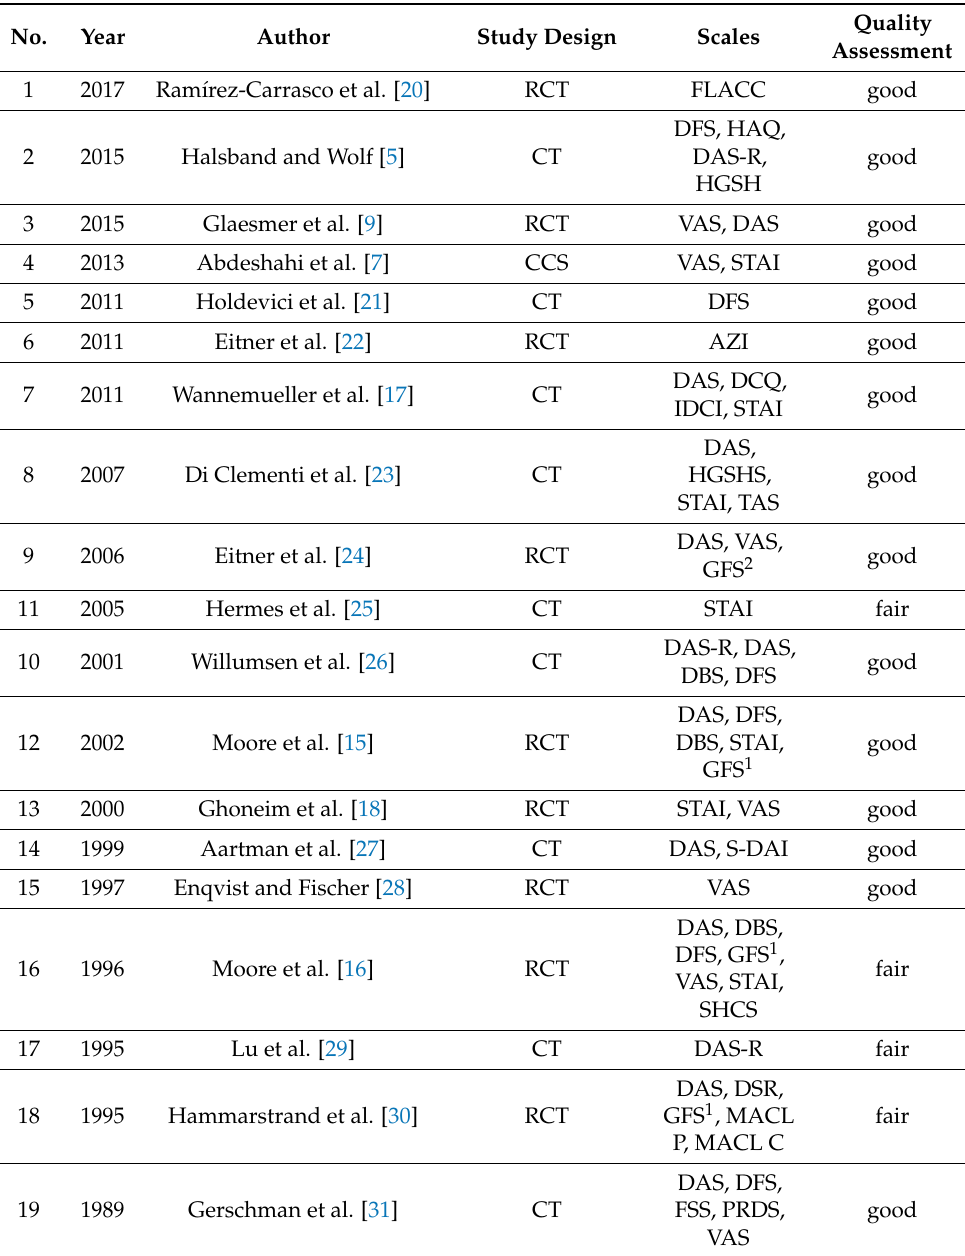
Table 1. General characteristics of the included studies. AZI, Aachen Dental Treatment Fear In- ventory; CCS , case-control study; Corah’s DAS/DAS-R, Corah’s Dental Anxiety Scale/Revised DAS; CT , clinical trial; DAS, Dental Anxiety Scale; DBS, Dental Beliefs Survey; DCQ, Dental Cog- nitions Questionnaire; DSR, Dental Situation Reactions; IDCI, Revised Iowa Dental Control Index; DFS, Dental Fear Scale; FLACC, Face, Legs, Activity, Cry, Consolability; FSS, Fear Survey Sched- ule; GFS 1 , Geer Fear Scale; GFS 2 , Gatchel Fear Scale; HAQ, Hypnotic Attitudes Questionnaire; HGSHS, Harvard Group Scale of Hypnotic Susceptibility; MACL, Mood Adjective Check List; PRDS, Positive Reaction to Dentistry Scale; RCT , randomized clinical trial; S-DAI, Short Dental Anxiety Inventory; SHCS, Stanford Hypnotic Clinical Scale for adults; STAI, State-Trait Anxiety Inventory; TAS, Tellegen Absorption Scale; VAS , Visual Analogue Scale. Quality No. Year Author Study Design Scales Assessment FLACC good